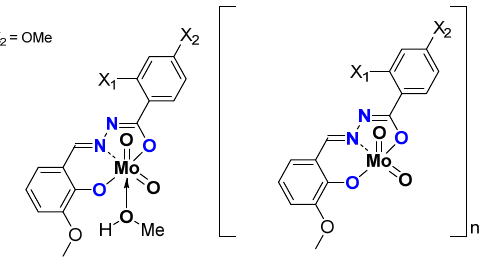
( b ) Figure 11. Schematic representation of neutral monomeric ( a ) and polymeric ( b ) Mo species studied containing the salicylaldehydato fragment in the hydrazonato ligand. With those compounds, catalysts tests with cyclo-octene have been performed using three types of oxidants (Table 8), TBHP in water (W), TBHP in decane (D), and H 2 O 2 in water (Table 8). As seen previously seen, TBHP in decane as oxidant gives the best results but TBHP in water gives relatively good results and is greener. With H 2 O 2 , the protocol